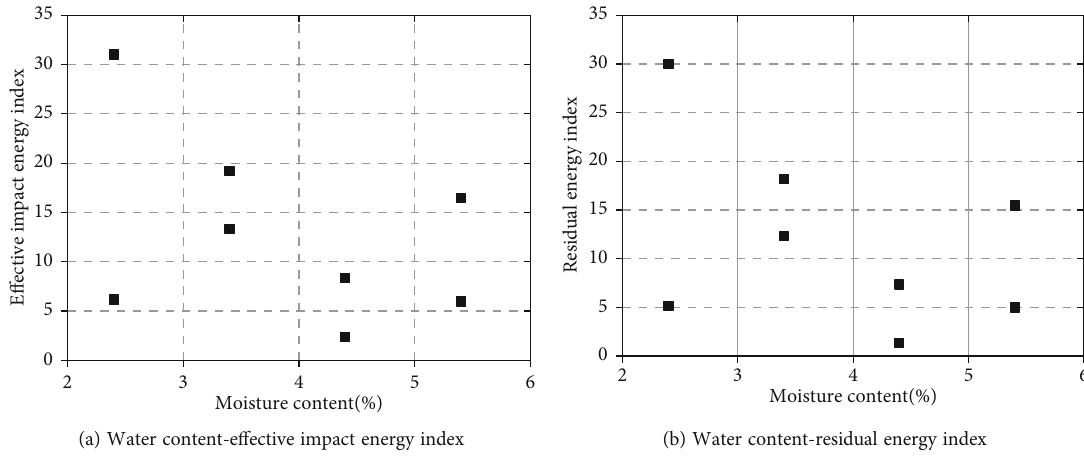
Figure 13: Water content-e ff ective impact energy index and water content-residual energy index of coal. Table 4: Performance indexes of coal samples with di ff erent water